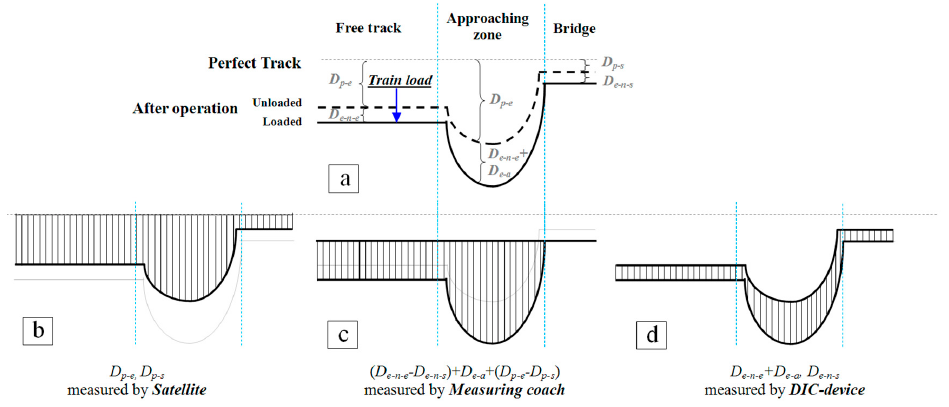
Figure 13. Schematic diagram of the measurement of the three systems. In ( a ), the unloaded track geometry after the operation is shown as the black dash line, while the loaded track geometry after the operation is shown as the solid black line. In ( b – d ), the deformation can be measured by the three systems is indicated as shade.